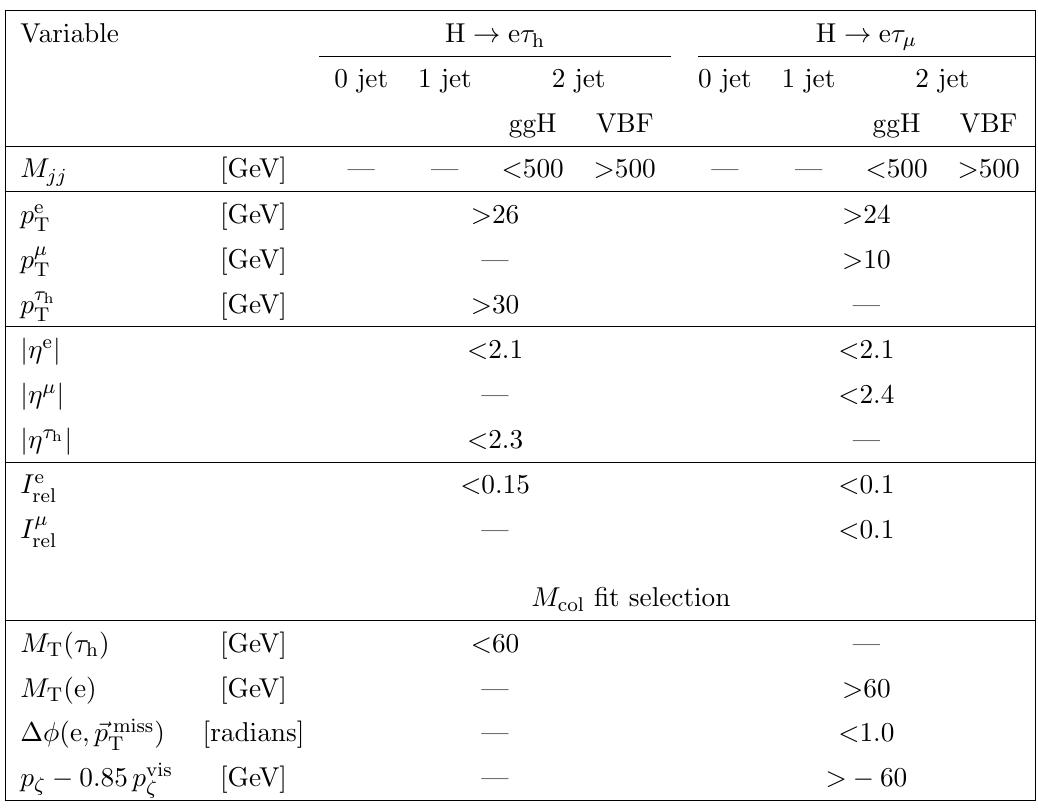
Table 2 . Event selection criteria for the kinematic variables for the H ! e (cid:28) channels. A BDT is trained after the loose selection. It uses the same input variables as for the H ! (cid:22)(cid:28) channel with the addition of the visible mass, M e The background used for the training is a sample of simulated tt